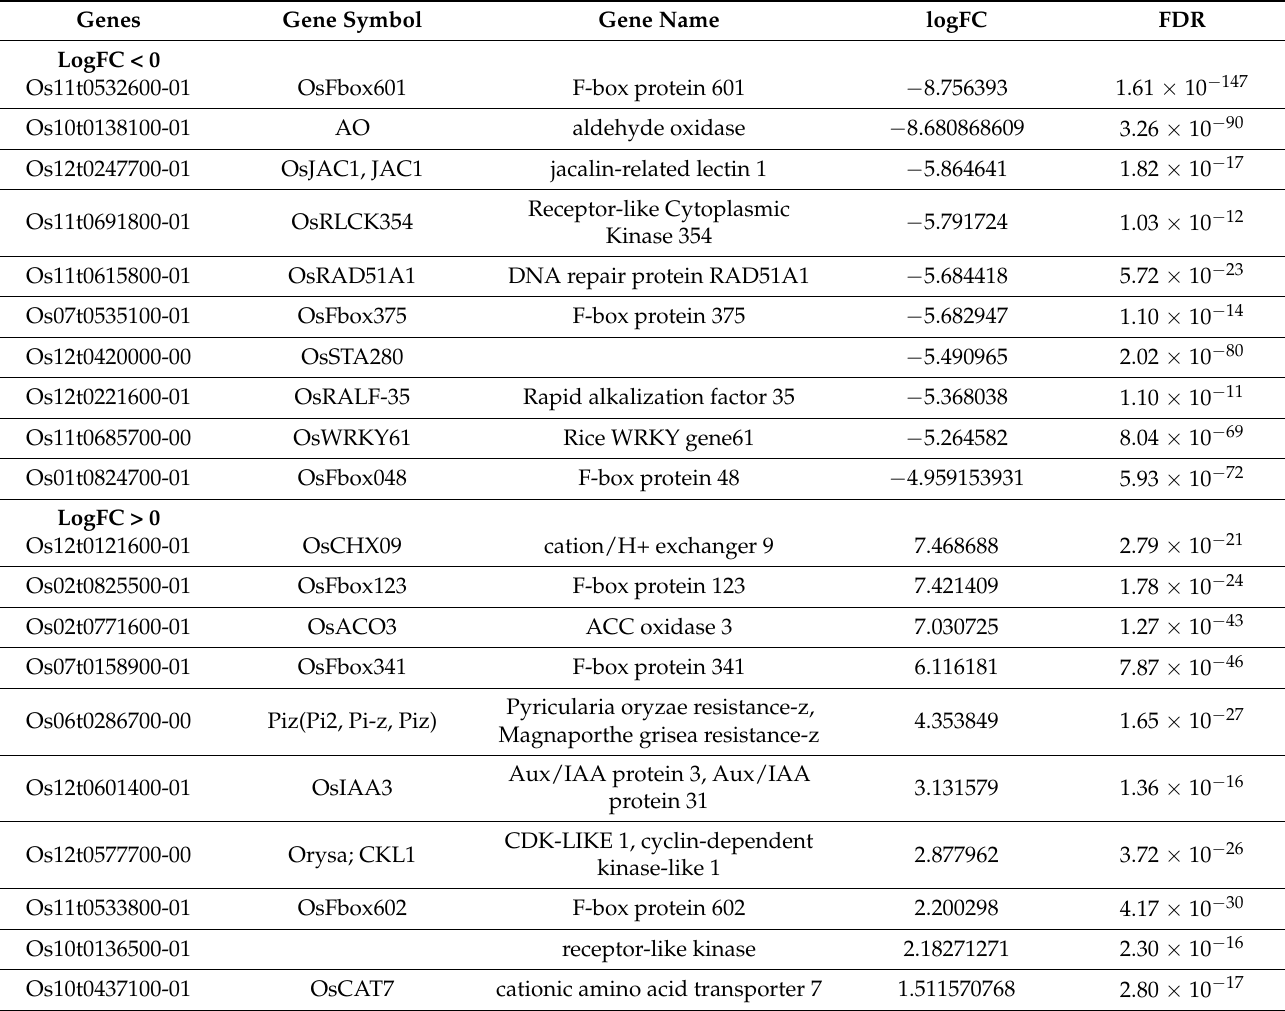
Table 1. Log-fold changes of top 10 down-regulated DEGs and top 10 up-regulated DEGs in Normal sample vs. PsGAPDH transgenic sample. Table 1 contains top 10 down-regulated DEGs and top 10 up-regulated DEGS with an adjusted p -value <